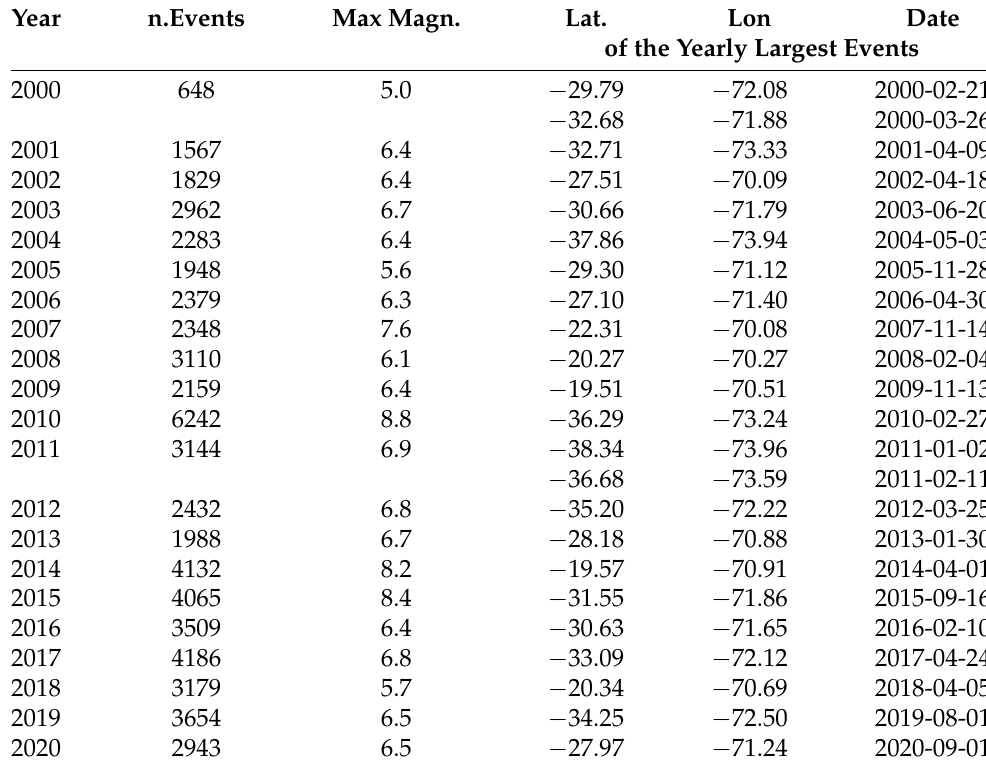
Figure 3. Left panel: Satellite image of the Southern America, with the evidence of the borders of Chile (in blue) and the tectonic plates (in gray); right panel: seismic events occurred in Chile from 2000 to 2020 in the two studied areas; in green, events in the Northern area and in red, events in the Southern area. Table 1. Summary statistics of the Chilean seismic events from 2000 to